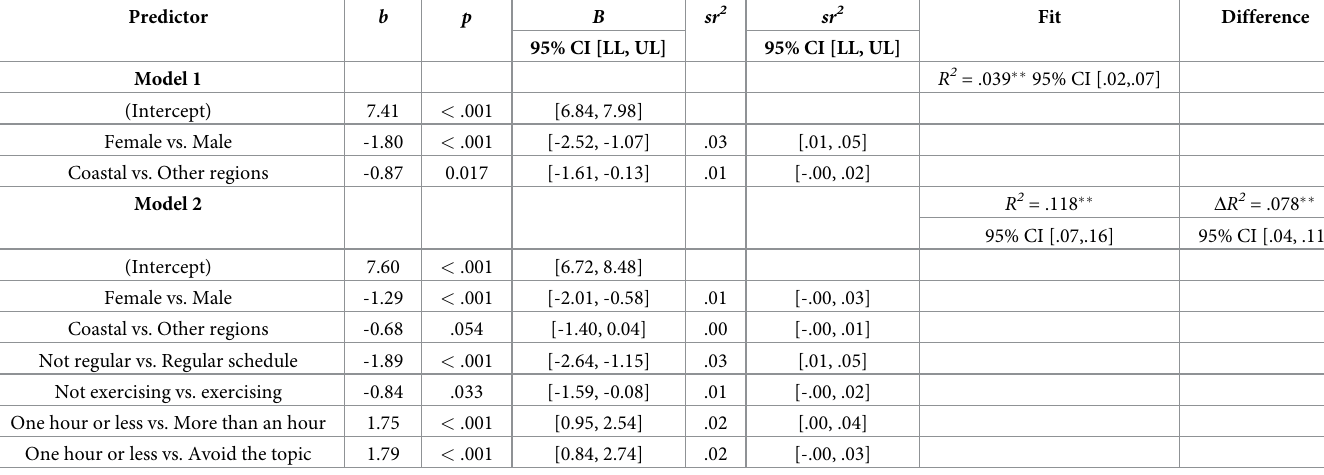
Table 3. Hierarchical linear regression analysis (unstandardized regression coefficients) for variables predicting GAD-7 total sum scores. Predictor b